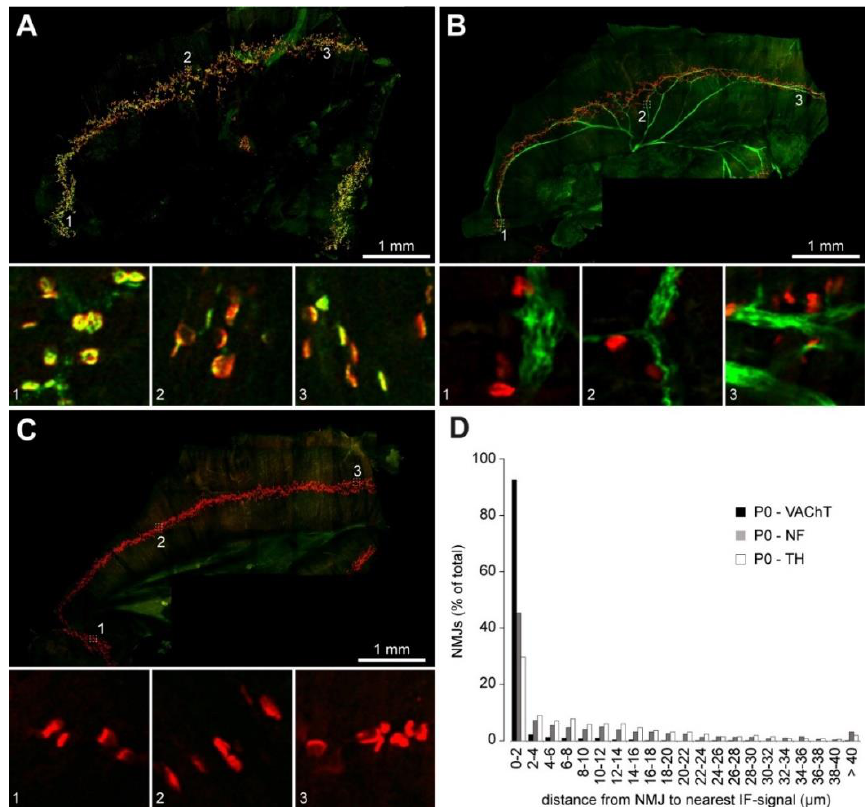
Figure 6. Quantitative analysis confirms interaction of NMJs with sympathetic ramifications in postnatal diaphragm muscles. Mouse diaphragm muscles from P0 mice were fixed, stained with BGT against NMJs (red signals in A – C ) and antibodies (green signals in A – C ) against VAChT ( A ) or neurofilament L ( B ). In ( C ), primary antibody was omitted. Then, muscles were imaged by high-resolution tile scanning confocal microscopy with a lateral resolution of 758 nm and a vertical step size ranging between 1 and 1.2 µm. Image acquisition was followed by deconvolution. Large pictures in ( A – C ) depict maximum z-projections of hemidiaphragms. Insets 1–3 show single optical sections from the correspondingly numbered boxed regions in the overview images. ( D ) shows a distribution plot indicating the distance of individual NMJs to the nearest corresponding immunofluorescence signal. Image data for P0—TH were as shown in Figure 5A. In total, 5986 NMJs were analyzed.